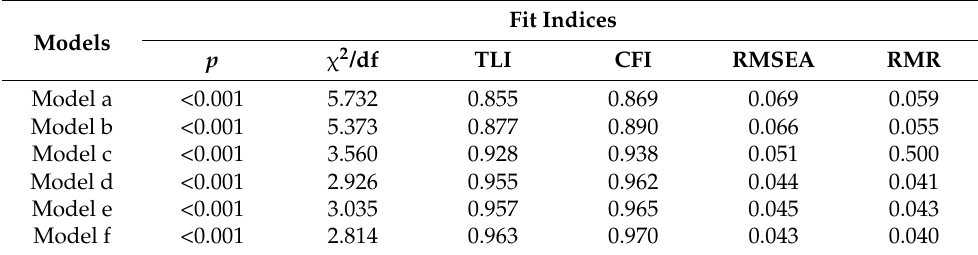
Table 7. Fit measures for the MES